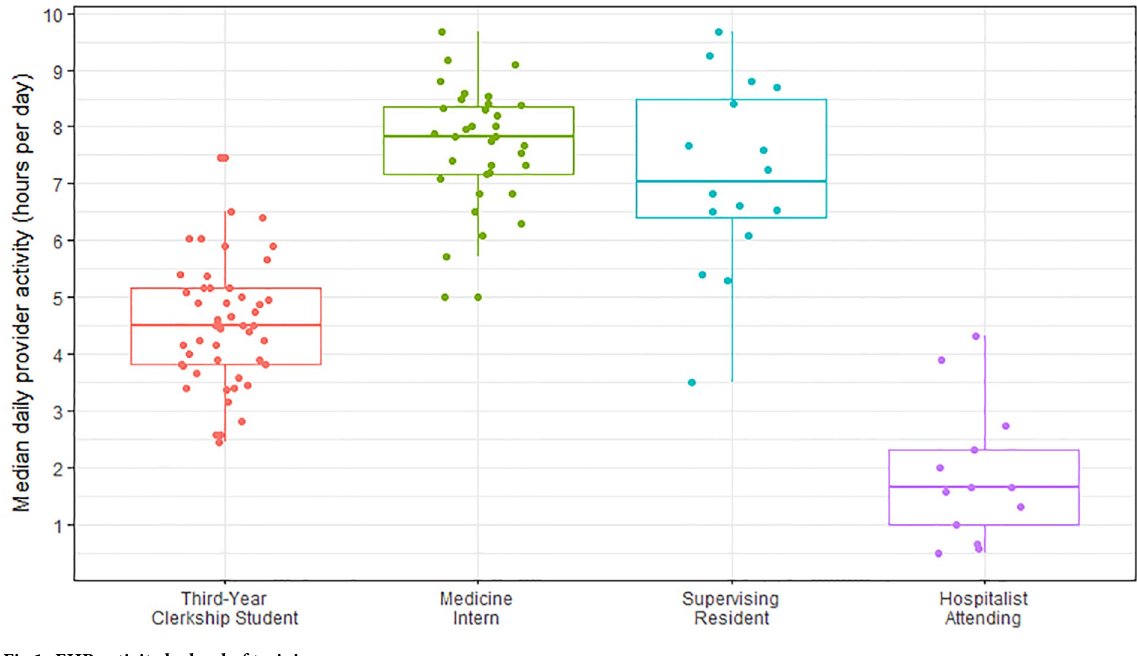
Fig 1. EHR activity by level of